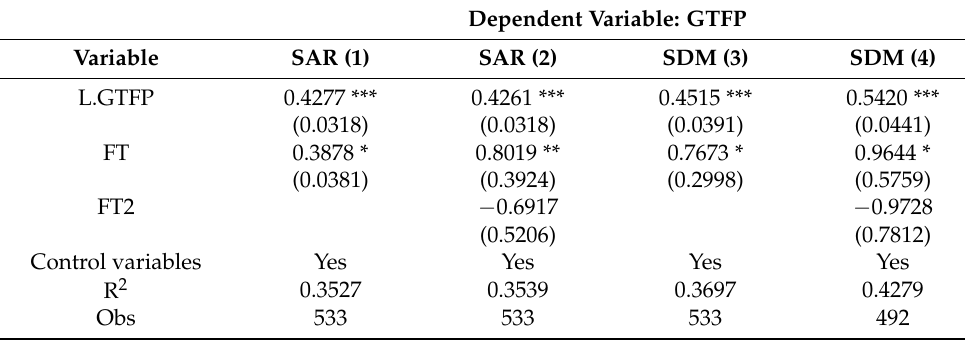
Table 9. Estimation results of effects of forest resource abundance on